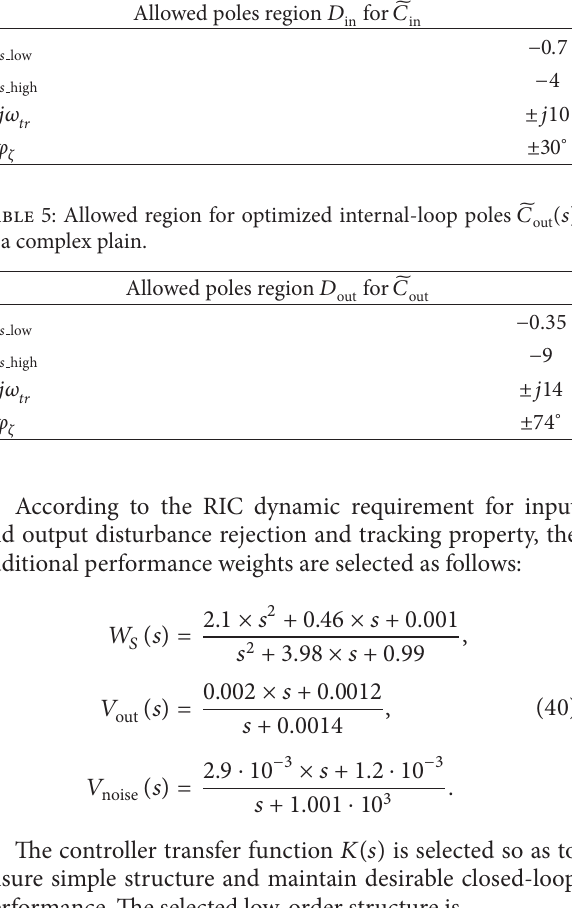
Table 2: Uncertainty parameters of the positioning system.